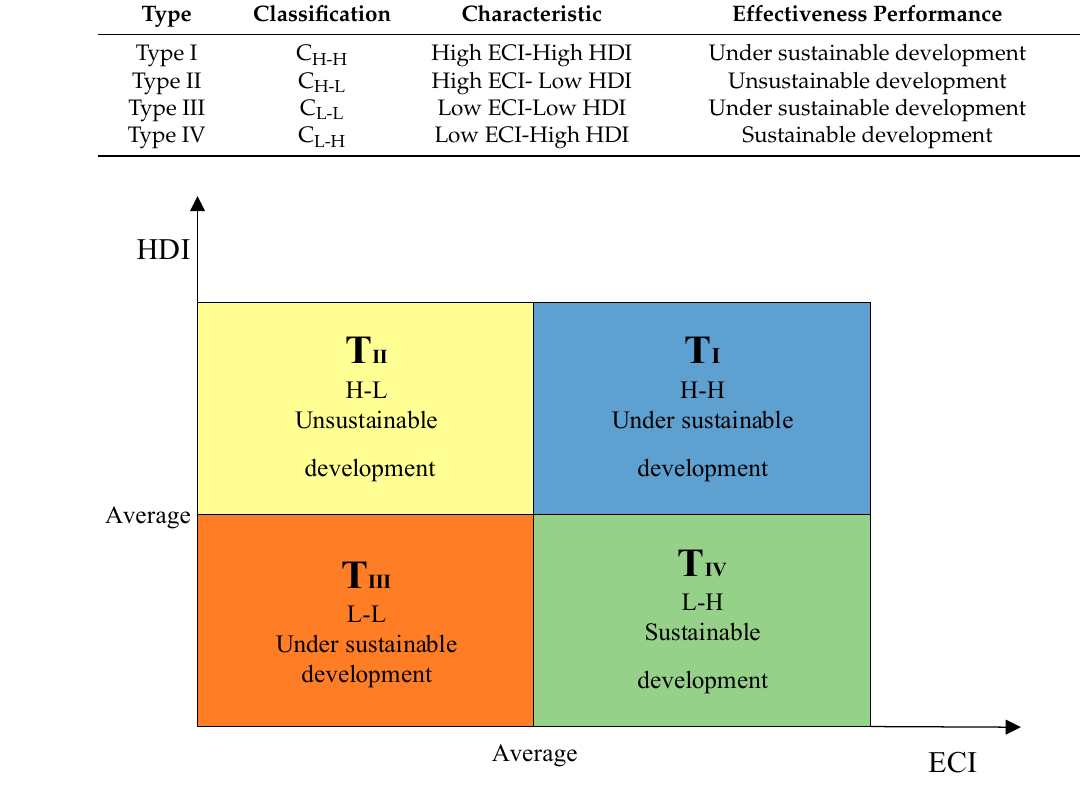
Figure 3. The four-quadrant evaluation framework for effectiveness assessment of EWP.